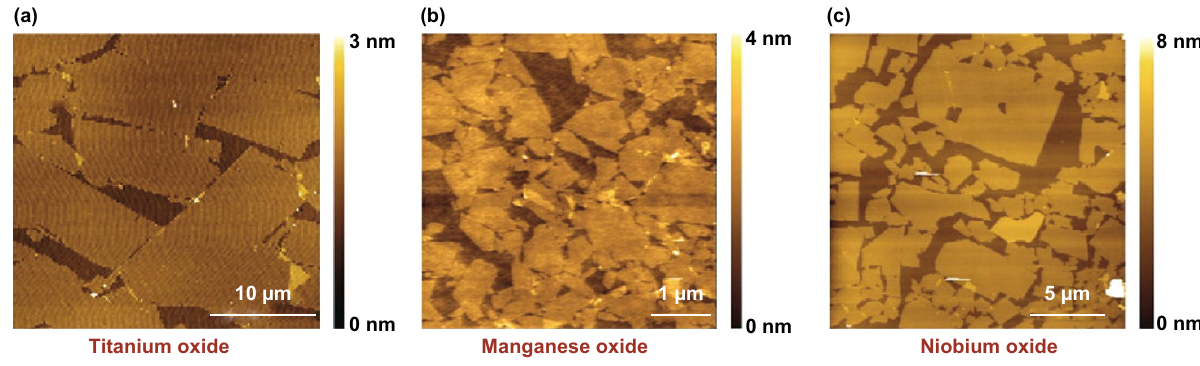
Fig. 12 AFM images of achieved 2D oxides from the soft chemical process. a Titanium oxide, b Manganese oxide, c Niobium oxide. Adapted with permission from Ref. [72]. Copyright 2015, American Chemical Society Publishing